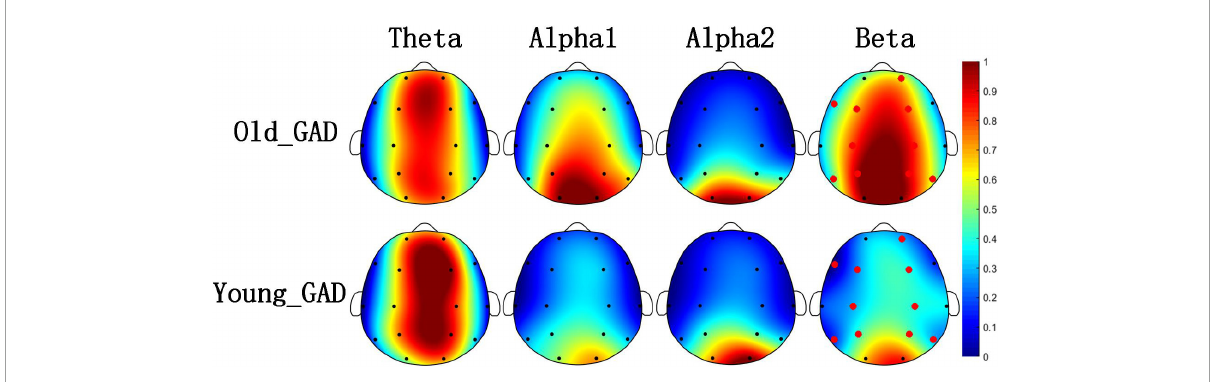
FIGURE1 Brain topography of average absolute power (AP) of four rhythms (theta, alpha1, alpha2, and beta). The average AP of Old_GAD and Young_GAD have been normalized between 0 and 1, so they shared the same color bar. The red dots indicated the significantly differential electroencephalogram (EEG) channels between the two groups ( p < 0.05).